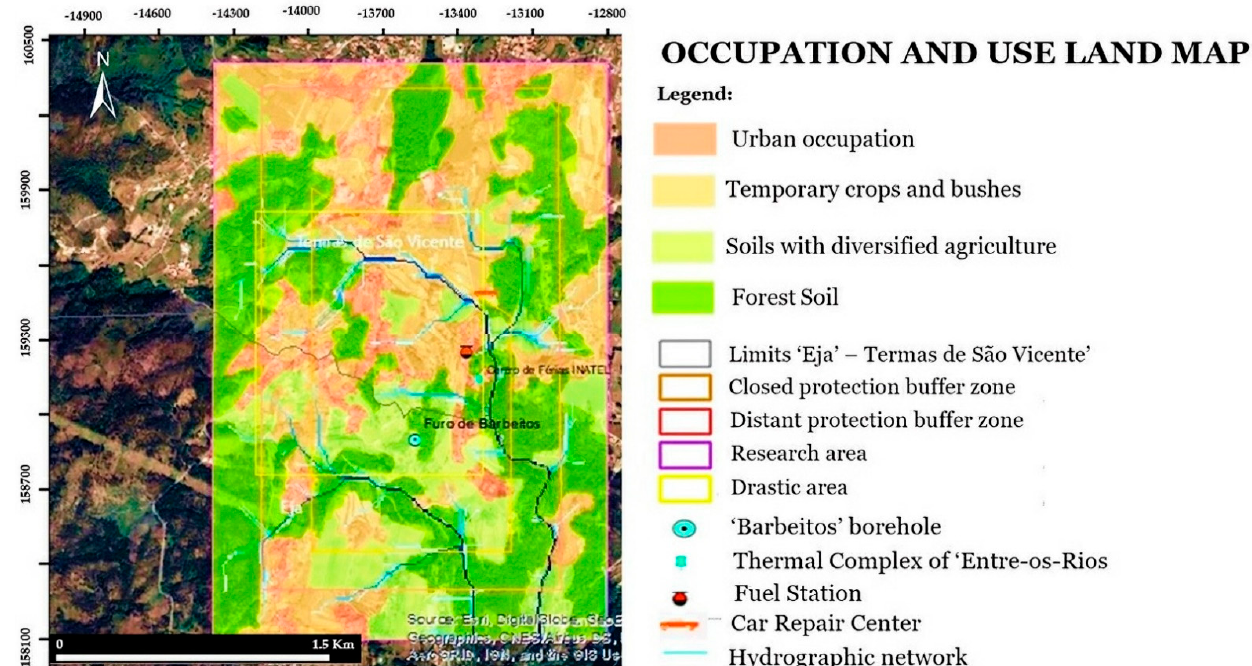
Figure 11. Map of use and land occupation type of the area surrounding the ‘Barbeitos’